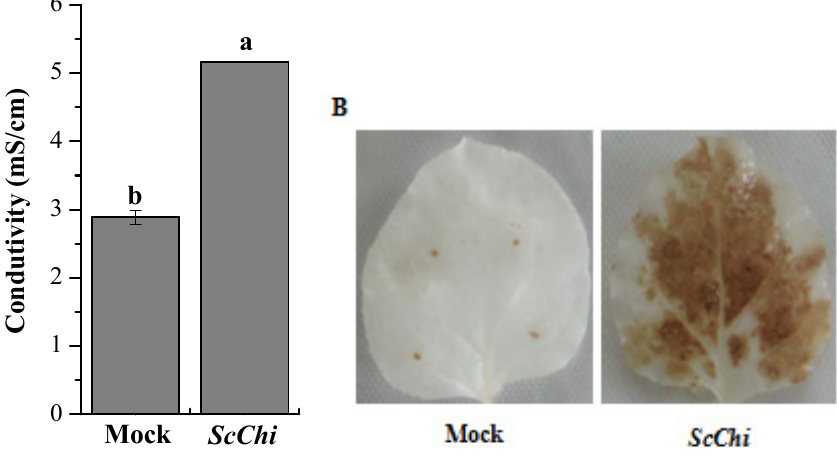
Figure 11. The transient expression of ScChi in Nicotiana benthamiana leaves. ( A ) Conductivity measurement of N. Benthamiana leaves infiltrated with the 35S::ScChi -containing Agrobacterium strain after 48 h. Mock: the Agrobacterium strain carrying 35S::00 . All data points are the means ± SE ( n = 3). Different lowercase letters indicate a significant difference, as determined by the least-significant difference test DAB (3,3'-diaminobenzidinesolution) staining with N. benthamiana leaves 48 h after Agrobacterium strain infiltration.